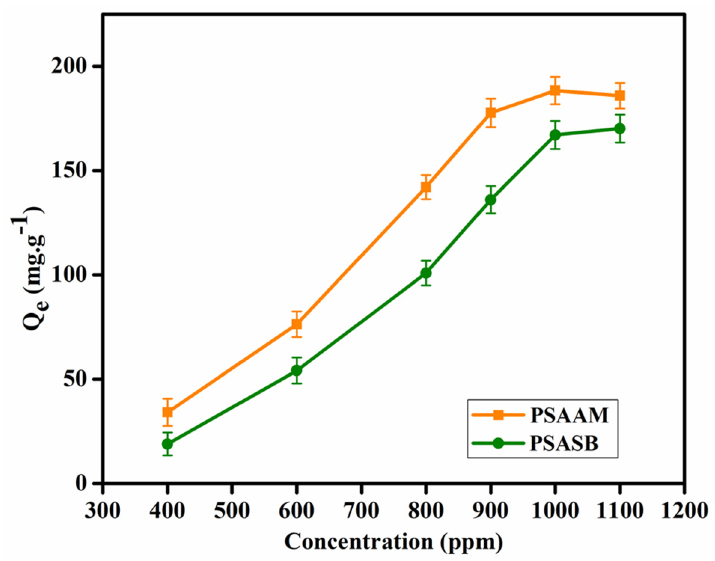
Figure 6. Cu (II) ion adsorption by PSASB and PSAAM in pH 5.5 at 30 °C. Table 2. Comparison of maximum adsorption capacity of Cu(II) ion by SA based materials. Sl. No.